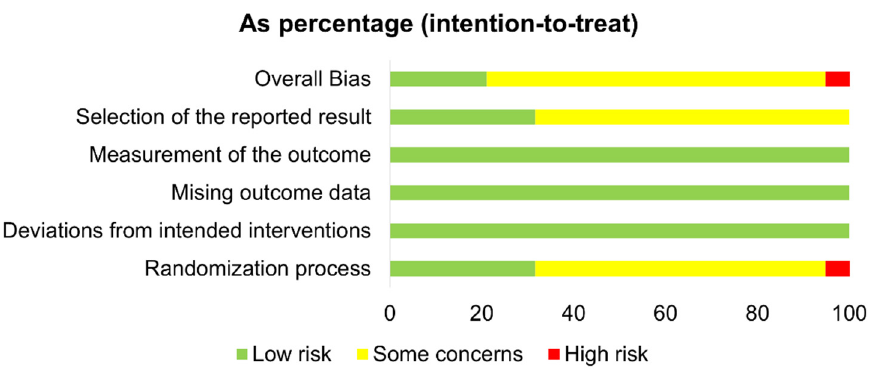
Figure 2. Risk of bias graph for the parallel design trials.